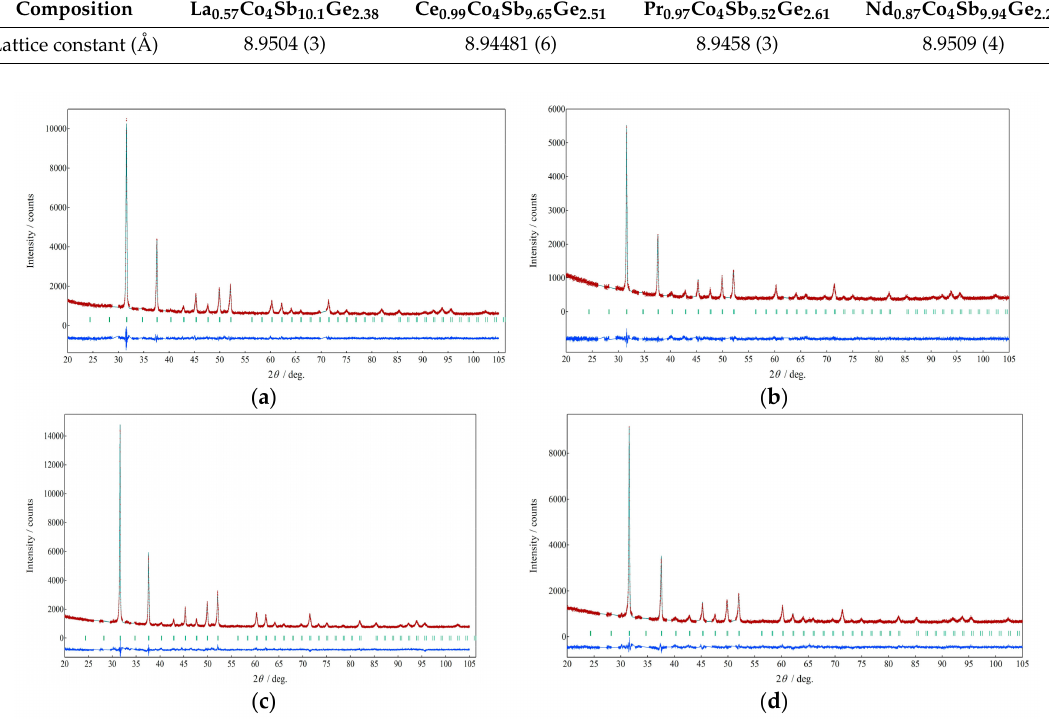
Figure 2. The XRD patterns and the results of pattern fitting; ( a ) La 0.57 Co 4 Sb 10.1 Ge 2.38 ; ( b ) Ce 0.99 Co 4 Sb 9.65 Ge 2.51 ; ( c ) Pr 0.97 Co 4 Sb 9.52 Ge 2.61 ; ( d ) Nd 0.87 Co 4 Sb 9.94 Ge 2.28 . The observed data are shown as red points and the calculated fits and difference curves are shown as green and blue lines, respectively. Tick marks show the calculated diffraction